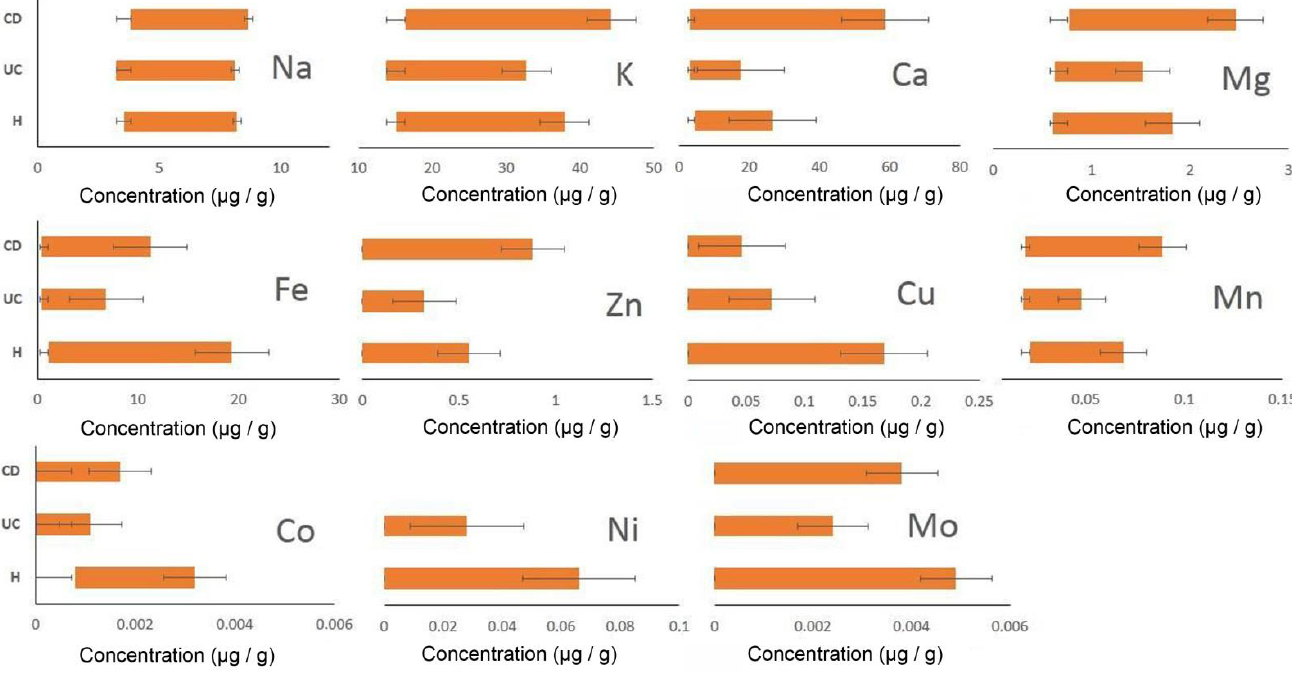
Figure 2. The content of elements in the sulfate-reducing bacteria SRB isolated from patients suffering from IBD. Notes: Crohn’s disease (CD), ulcerative colitis (UC), healthy (H).